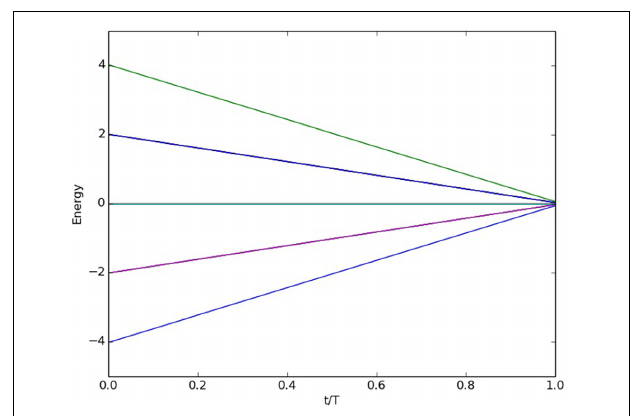
FIGURE 1 | Time-dependent eigenspectrum for p = 4 orthogonal memories stored in a network of n = 4 neurons in the absence of bias, = 0. For orthogonal memories, the spectrum is the same for the Hebb, θ i Storkey, and projection learning rules.